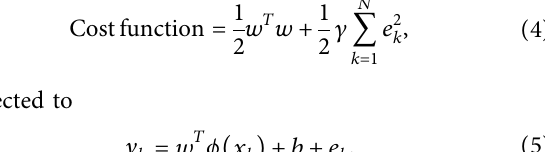
Figure 1: The general process of the PSO-LSSVM approach